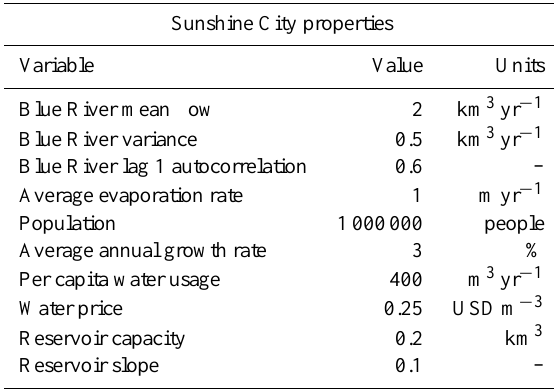
Table 1. Summary of Sunshine City